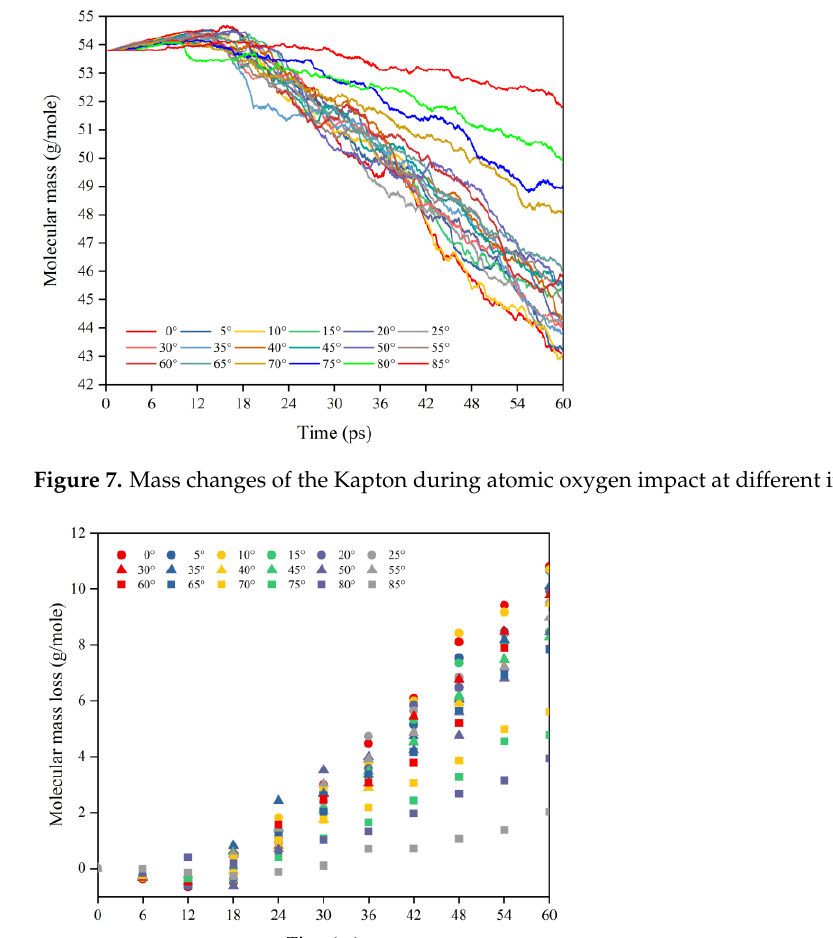
Figure 7. Mass changes of the Kapton during atomic oxygen impact at different incidence angles. Figure 8. Mass loss of the Kapton during atomic oxygen impact at different incidence